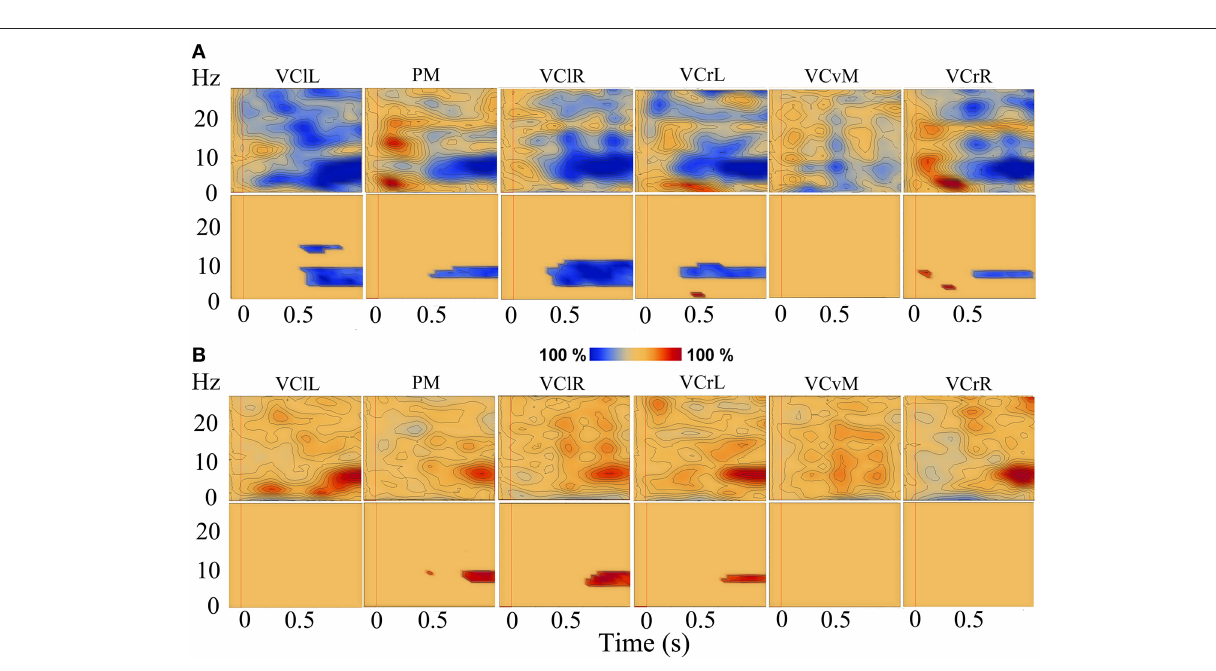
FIGURE 4 | TSE maps (top) and corresponding TSE probability maps ( P < 0.05 ; bottom). TSE data in the low speed condition (A) and in the static condition (B) for a typical participant, in sources (from left to right): VClL, PM, VClR, VCrL, VCvM, and VCrR. Red vertical line at t = 0 indicates stimulus